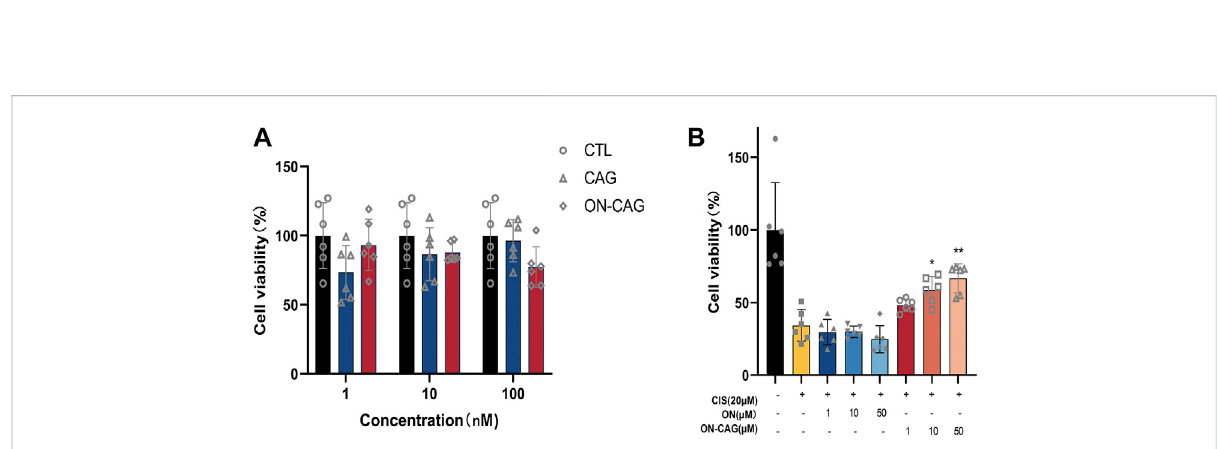
FIGURE 5 The effect of ON, CAG, and ON-CAG on HK-2 cell viability. (A) HK-2 cells were treated with CAG or ON-CAG for 24 h by CCK8 assay, and the concentration of each compound was 1, 10, 100 nmol/L. Data were presented as the mean ± S.E.M. (n = 6). CTL: Control; ON: Oligonucleotides; CAG:Cycloastragenol. (B) HK-2cellswerestimulatedwith20 μ mol/Lcisplatinfor24 handthentreatedwithdifferentconcentrations(1,10,50 μ mol/ L) of ON or ON-CAG for 24 h. Data were presented as the mean ± S.E.M. ( n = 6). ** p < 0.01 compared with the cisplatin group. CTL: Control; CIS: